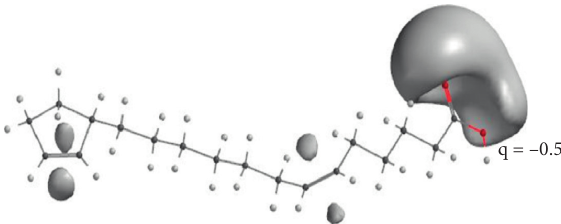
Figure 6: Electrostatic potential map of gorlic acid.